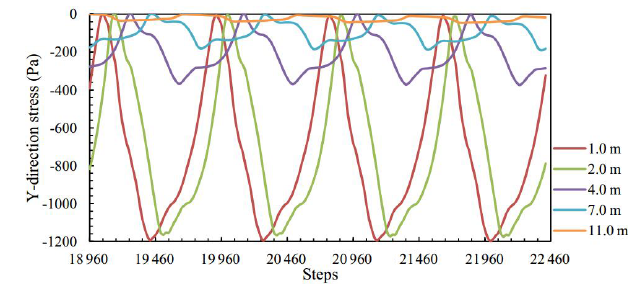
Figure 5. Y -direction stresses at different distances from the bottom of the